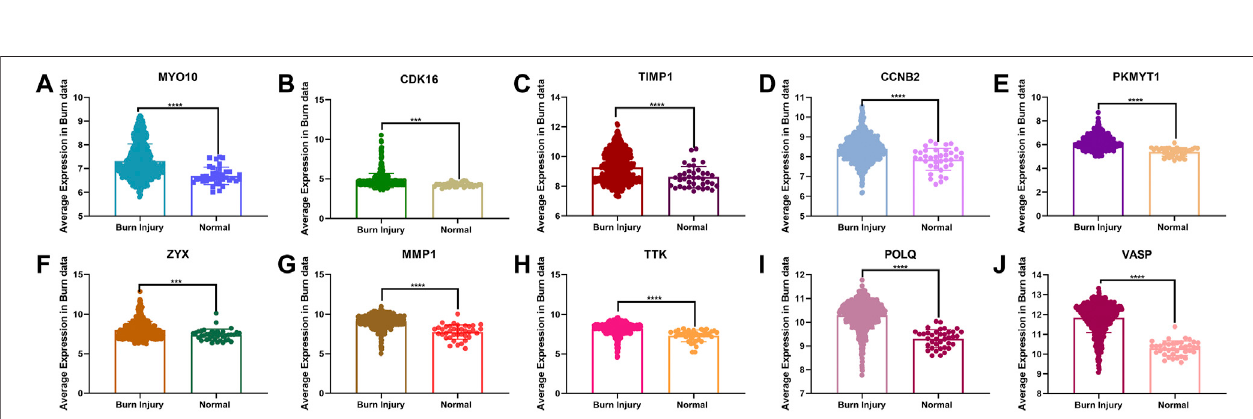
Frontiers in Genetics |